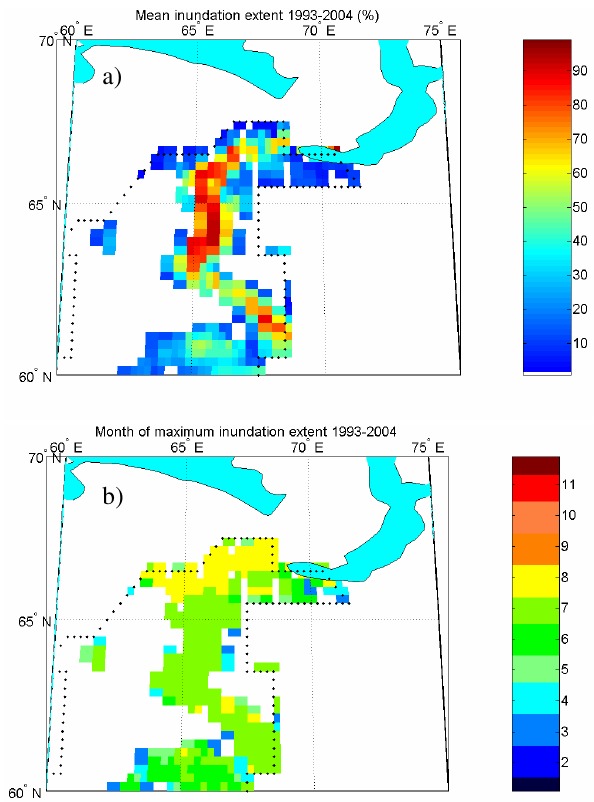
Fig. 3. (a) The 1993–2004 mean fractional inundation at yearly Figure 3. a) the 1993–2004 mean fractional inundation at yearly maximum (%) b) the average 1 maximum (%); (b) the average month of the year (1993–2004) month of the year (1993-2004) when the fractional inundation is maximum (in month).2 when the fractional inundation is maximum (in month).